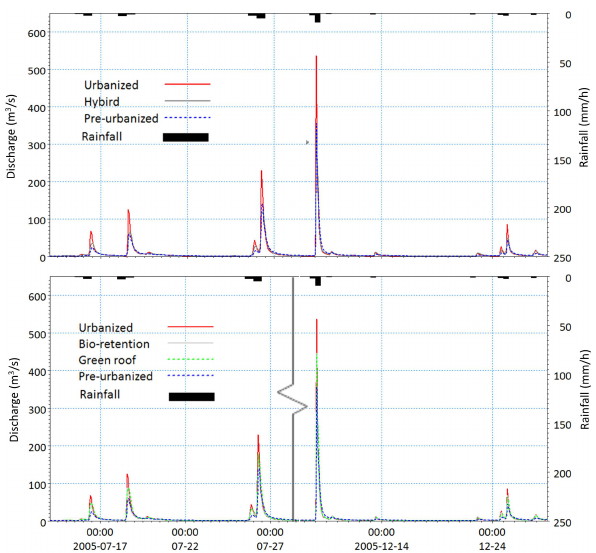
Fig. 6. Peak discharges at catchment outlet under different scenar- ios.